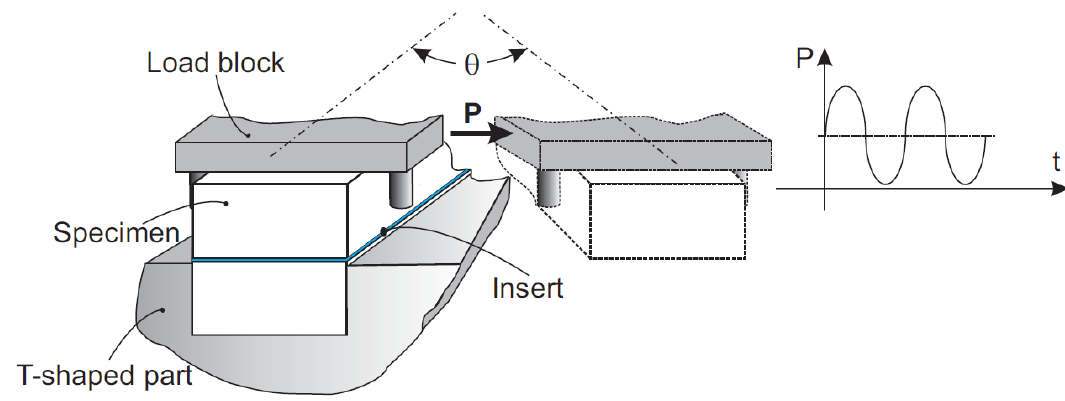
Figure 2. Detail of the method for applying the load.